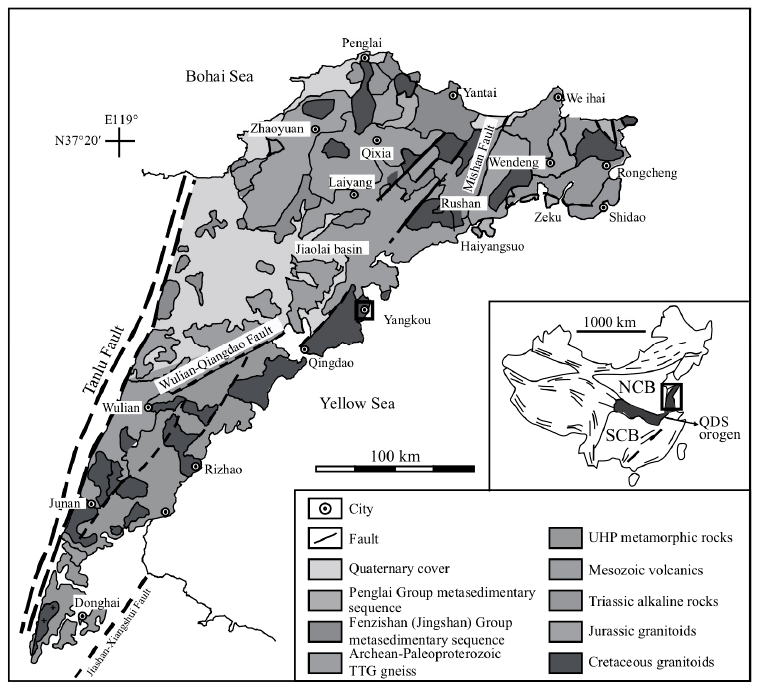
Figure 1. Regional geological map of Sulu UHP metamorphic belt [27]. Yangkou area, where the mine is located, is in the southern part of Jiaodong Peninsula, about 50 km away from the urban area of Qingdao, Shandong Province. It is located in the middle of the Sulu UHP metamorphic belt. The main exposed rocks are ultrabasic rocks (including serpentinite and serpentinized peridotite), eclogite, metagabbro, and wall rock granite gneiss as a part of the metamorphic belt [25,26]. The ultrabasic rock blocks are distributed in belts with different scales [23] and in abrupt contact with granite gneiss.